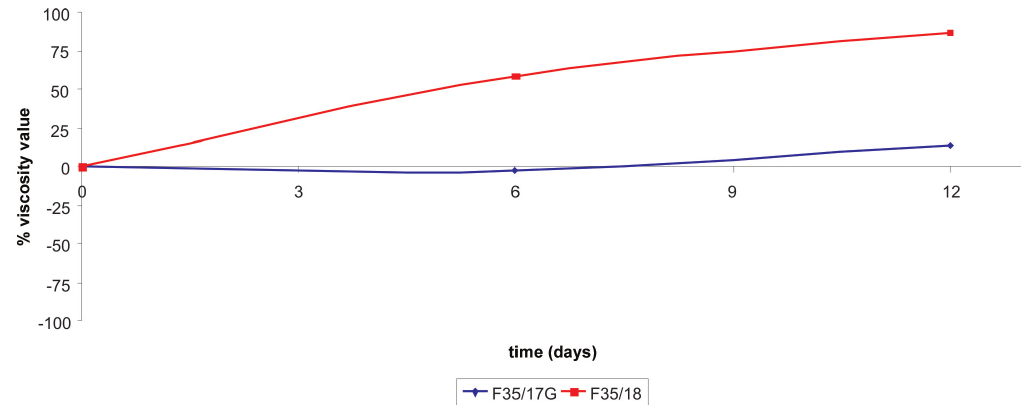
FIGURE 7 - Percentage variation of apparent viscosity value for the test formulations F35/18 and F35/17G in the Freezing/Defrosting Cycles (45.0 ± 2.0 ºC / -10.0 ± 1.0 ºC) storage condition in the Accelerated Stability Study.